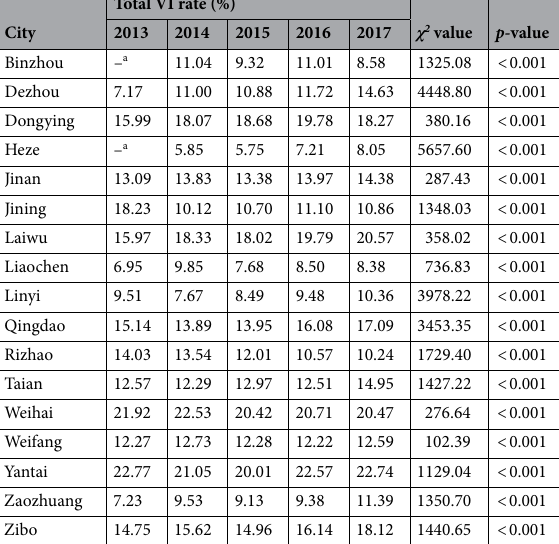
Table 2. Vision impairment (VI) of children in different cities of Shandong province from 2013 to 2017. a The symbol (‘-’) represents a missing value.